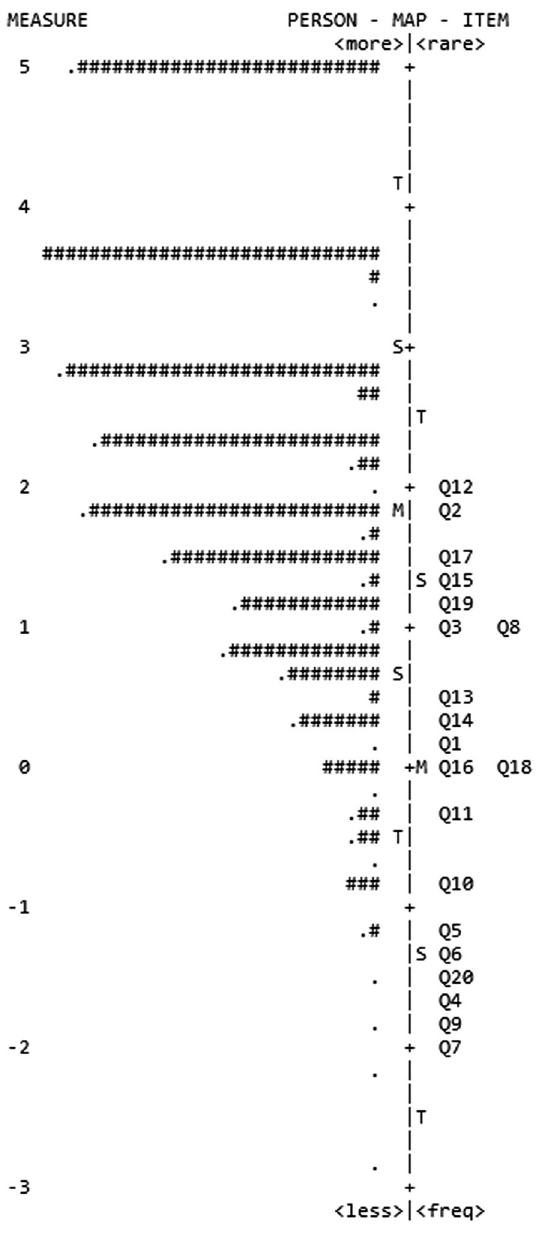
FIG. 1. The person-item map shows the distribution of student abilities on the left-hand side and the distribution of item difficulties on the right-hand side displayed on the same logit scale. Each “ hash ” represents four students and each “ dot ” represents one to three students. The TUV items are labeled as Q1 – Q20. M denotes the mean of each distribution; S denotes 1 standard deviation, and T 2 standard deviations from the